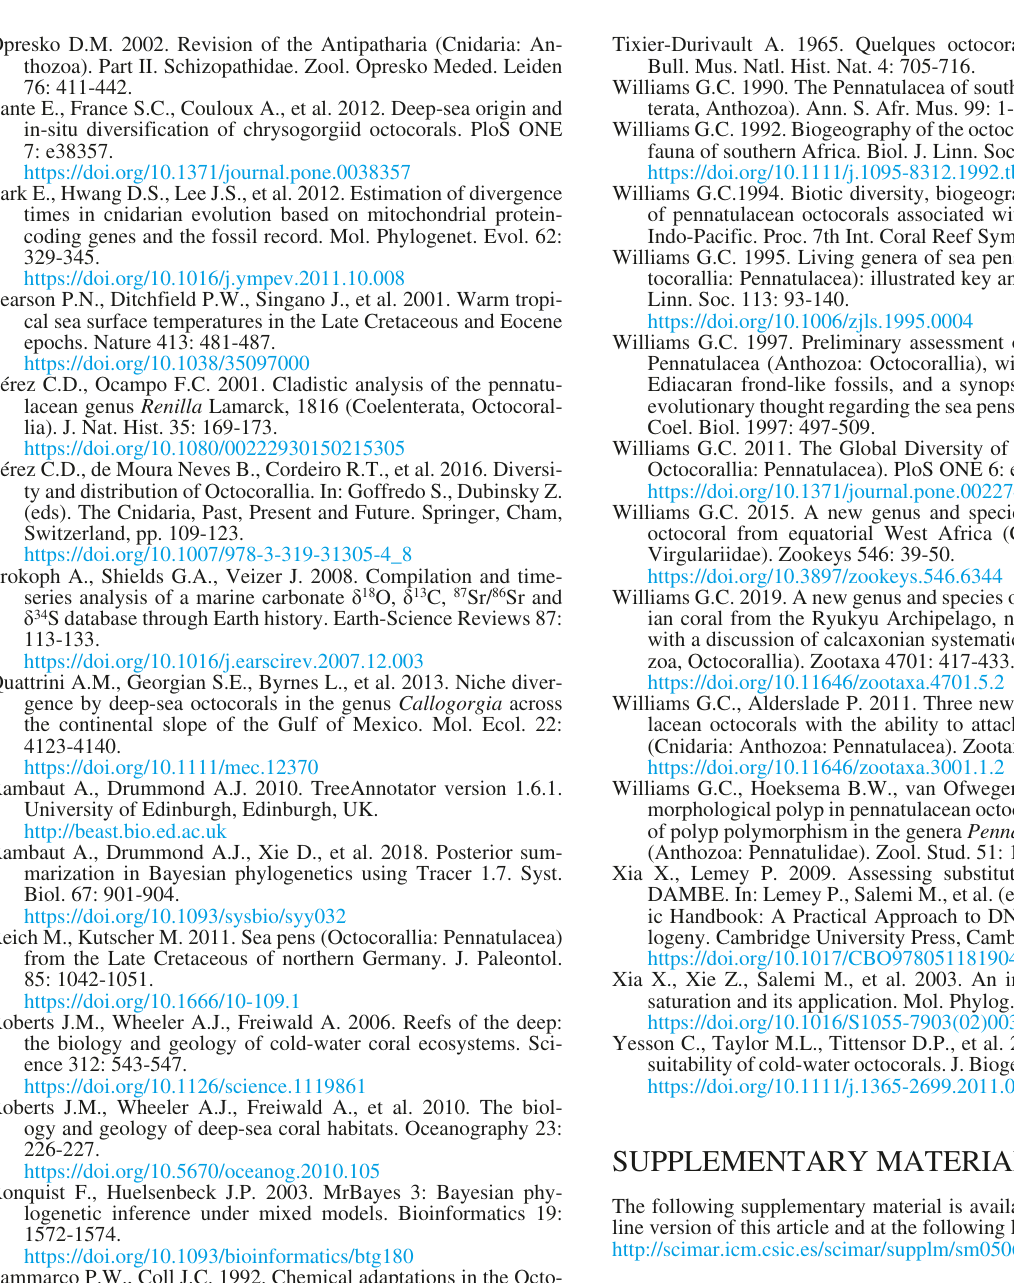
Fig. S1. – Calibrated tree from time divergence analysis. Phyloge- netic relationships were based on Bayesian inference methods for combined regions mtMutS + Cox1 + 28S . Bars indicate the 95% highest posterior density with the inferred mean age. Red dot indicates fossil calibration point. Fig. S2. – Phylogenetic relationships in the order Pennatulacea based on the maximum likelihood method for the marker mt- MutS. Posterior probability and bootstrap supporting values are indicated on the different nodes. See Table S3 for species and GenBank accession numbers used in this tree. Fig. S3. – Phylogenetic relationships in the order Pennatulacea based on the maximum likelihood method for the marker Cox1. Posterior probability and bootstrap supporting values are indi- cated on the different nodes. See Table 1 for species and Gen- Bank accession numbers used in this tree. Fig. S4. – Phylogenetic relationships in the order Pennatulacea based on the maximum likelihood method for the concatenated mitochondrial markers mtMutS + Cox1. Posterior probability and bootstrap supporting values are indicated on the different nodes. See Table 1 for species and GenBank accession numbers used in this tree. Fig. S5. – Phylogenetic relationships in the order